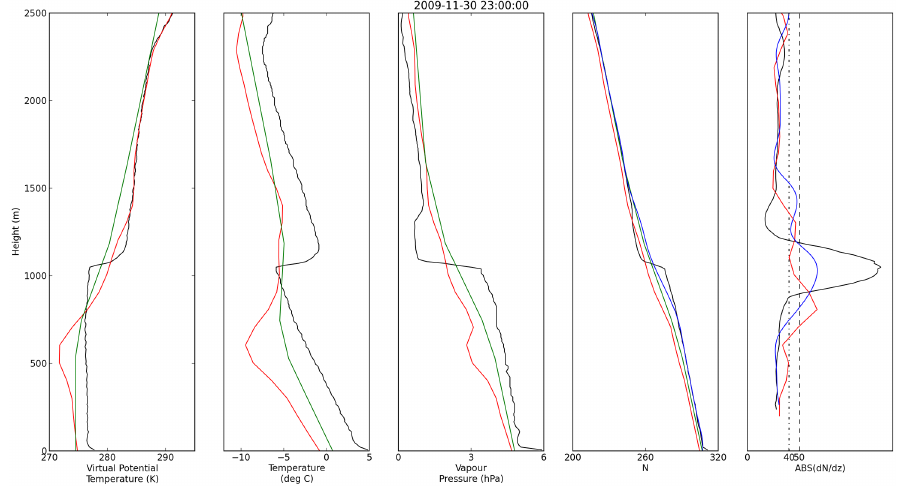
Figure 3. Profiles for 30 November 2009 at 23Z for MAC (black), COSMIC wet (red), COSMIC raw (blue), and ECMWF (green). Vertical dashed (dash-dotted) line represents the threshold defining main (secondary) break